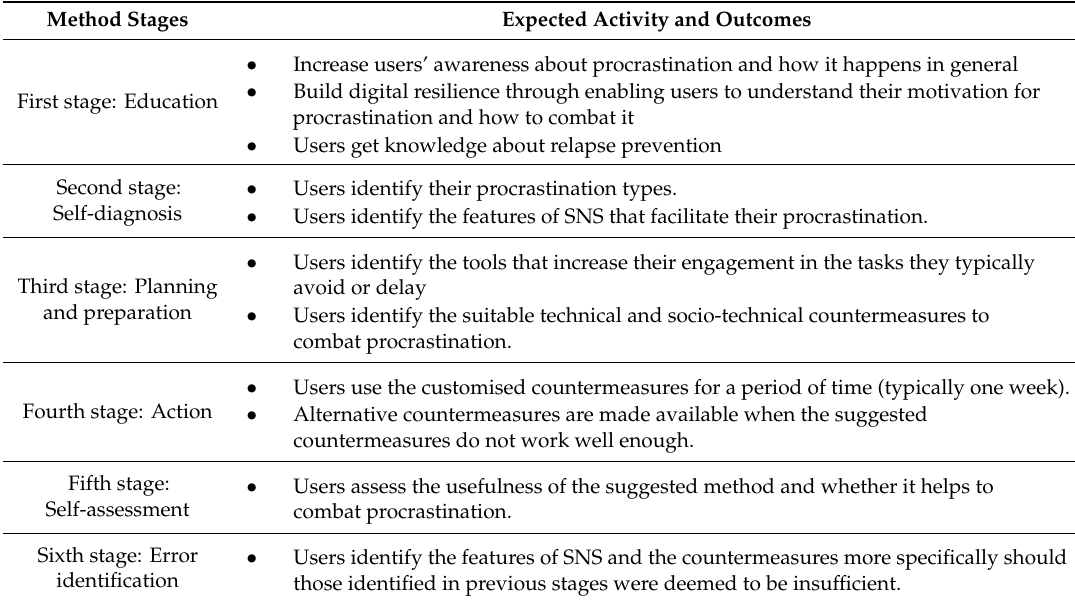
Table 1. Stages of D-Crastinate method and their expected activities and outcomes.